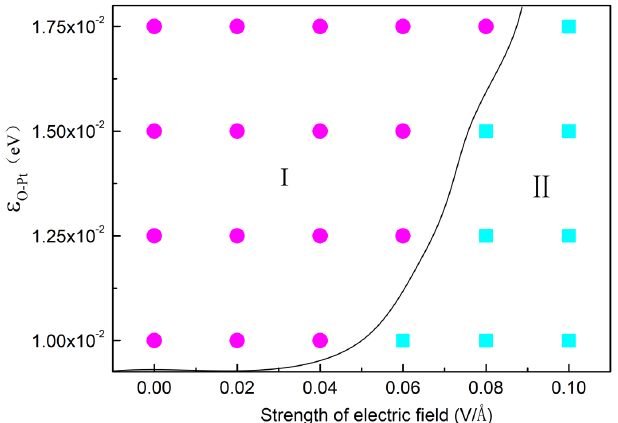
Figure 8. The configuration of cluster forming on different wettability surface under different electric field, where square represents circular cluster, circular represents columnar cluster.